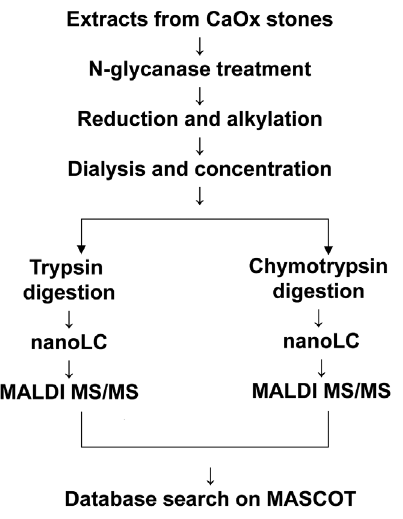
Figure 3. Procedure for protein profiling of CaOx renal stones. In order to analyze the protein compositions of individual CaOx stones, extracts from CaOx renal stones were subjected to protease digestion in solution and analyzed using nano-LC and MALDI-MS/MS as summarized in this scheme.